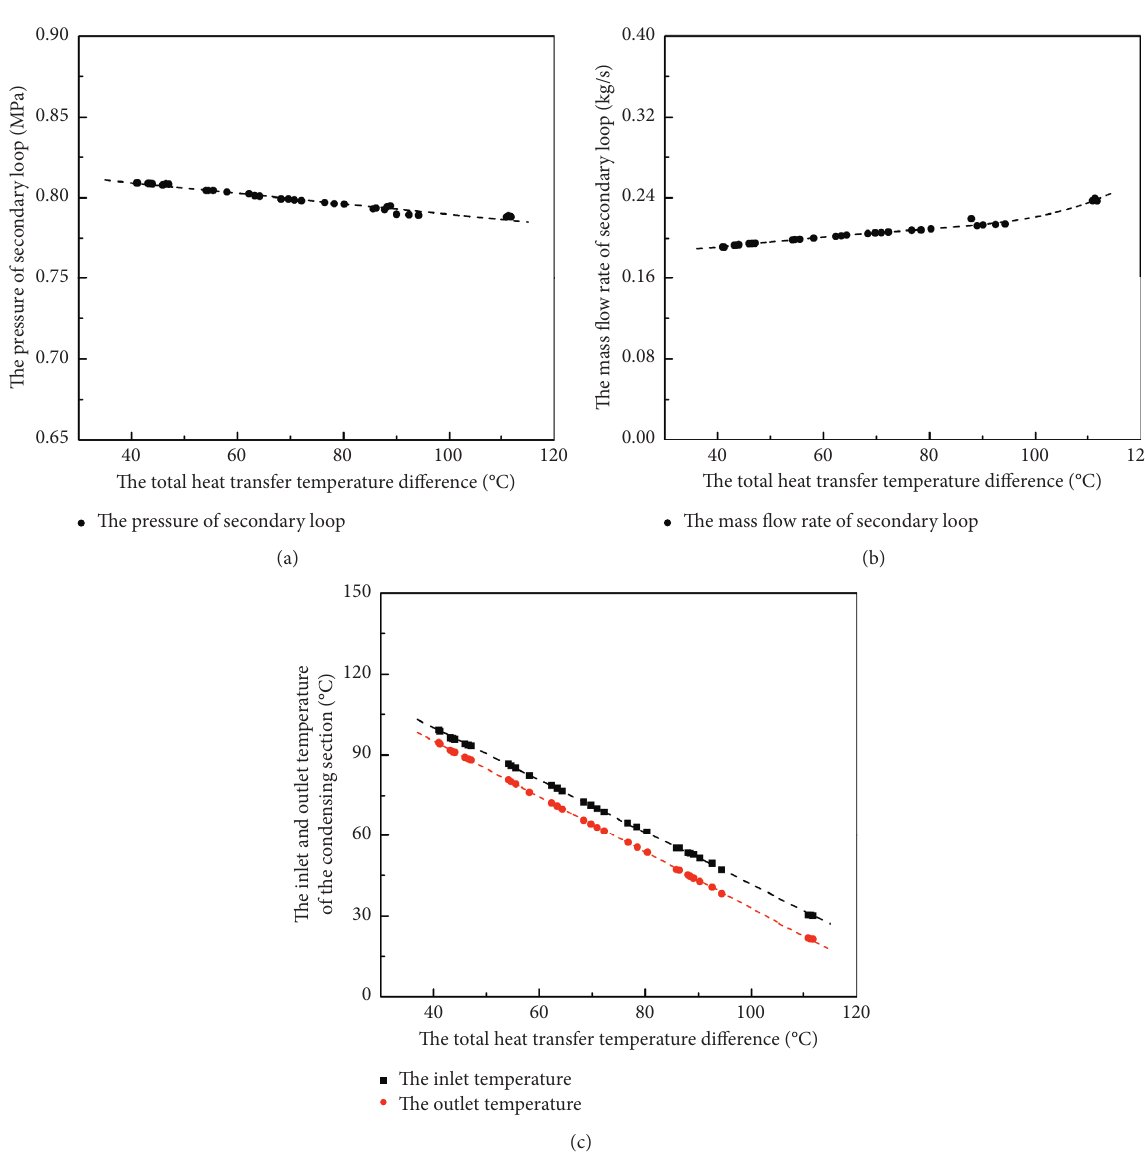
Figure 5: The pressure and flow rate of the secondary loop. (a) The pressure in the secondary loop. (b) The flow rate of the secondary loop. (c) The inlet and outlet temperature of the condensing section.